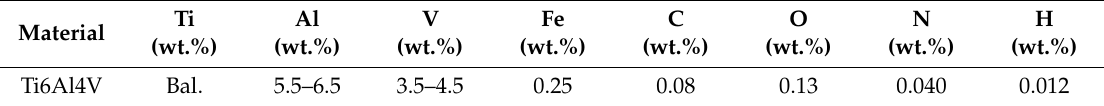
Table 2. Chemical composition of titanium alloy Ti6Al4V.